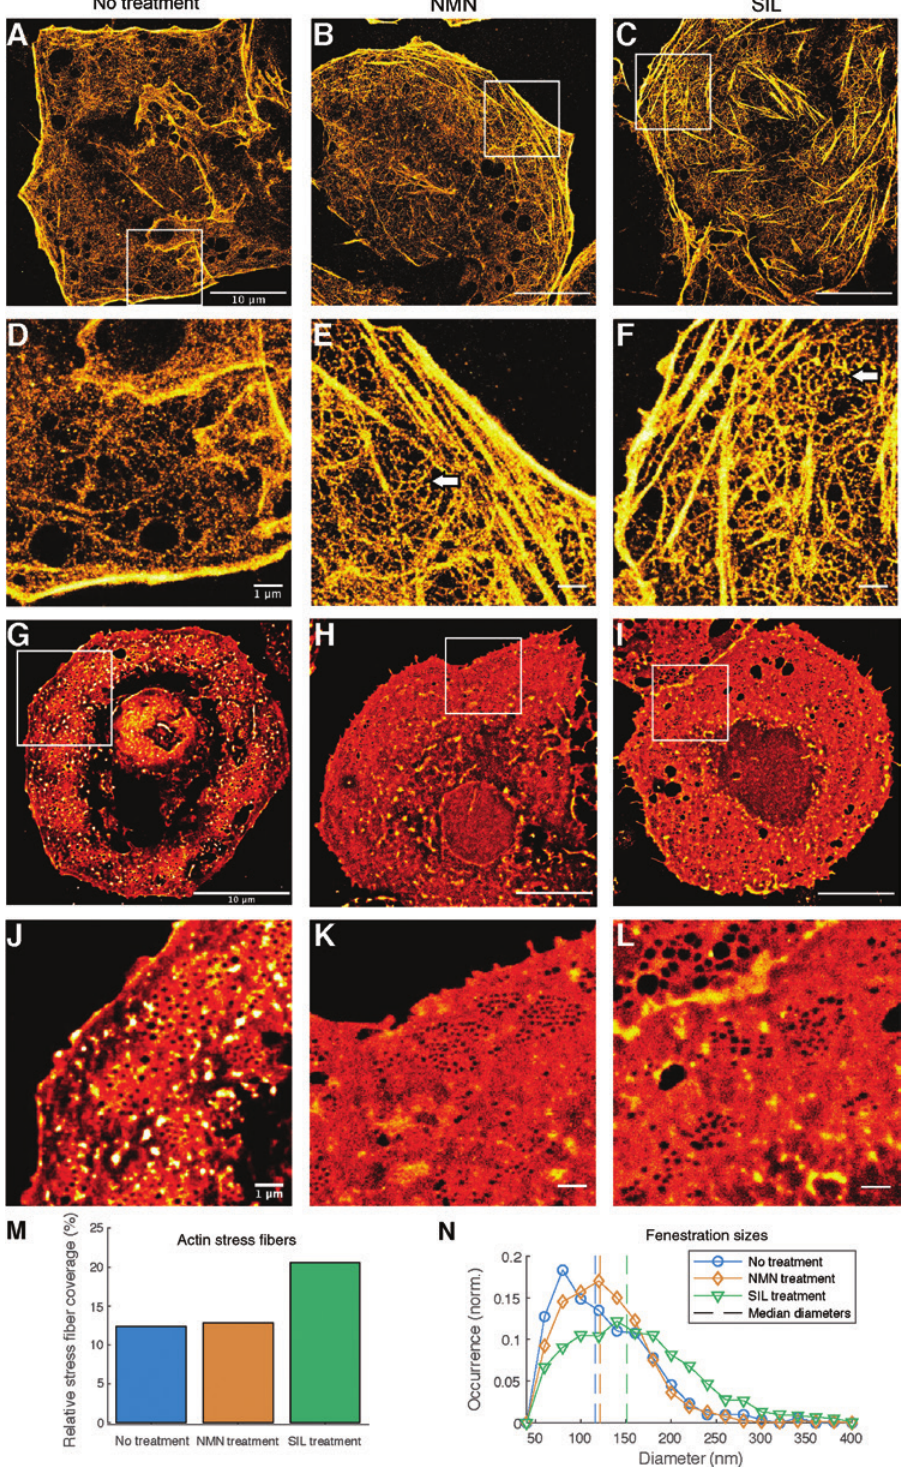
Figure 4: Membrane and actin staining in LSECs treated with NMN and sildenafil. (A–F) dSTORM images of drug-treated rat LSECs in OxEA buffer, stained for actin with phalloidin-AF488: (A, D) Control; (B, E) 333 μ g/ml NMN; (C, F) 60 ng/ml SIL. Insets (D–F) show a detailed comparison of drug effects compared to controls. Arrows in E and F indicate actin rings that typically delineate fenestrations. (G–I) Images of drug-treated rat LSECs, stained with Vybrant DiD in GODCAT-1 buffer, (G, J) Control; (H, K) NMN; (I, L) SIL. (M) Plot of relative percentage of stress fibers as a total of actin staining vs. control, NMN and SIL treatment (n = 1 for each point). The relative proportion of stress fiber actin within total actin increases particularly upon SIL treatment. (N) Histogram of occurrence vs. fenestration size after challenge with NMN and SIL. Fenestration size increases after NMN and SIL treatment. All imaging was in TIRF